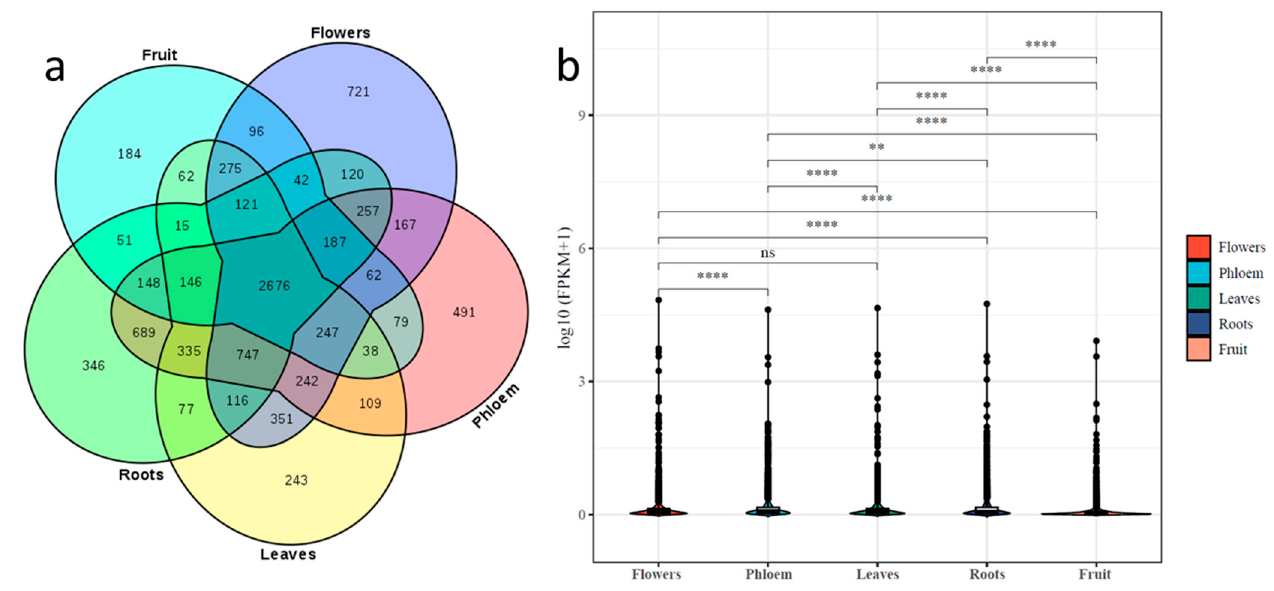
Figure 3. Tissue–specific expression characteristics of the lncRNAs identified. ( a ) Venn diagram showing the number of lncRNAs identified in five tissues of apples. ( b ) The overall abundance patterns of lncRNAs according to FPKM calculations (ns: no significant difference; **: significant difference level at p < 0.01; ****: significant difference level at p < 0.0001).